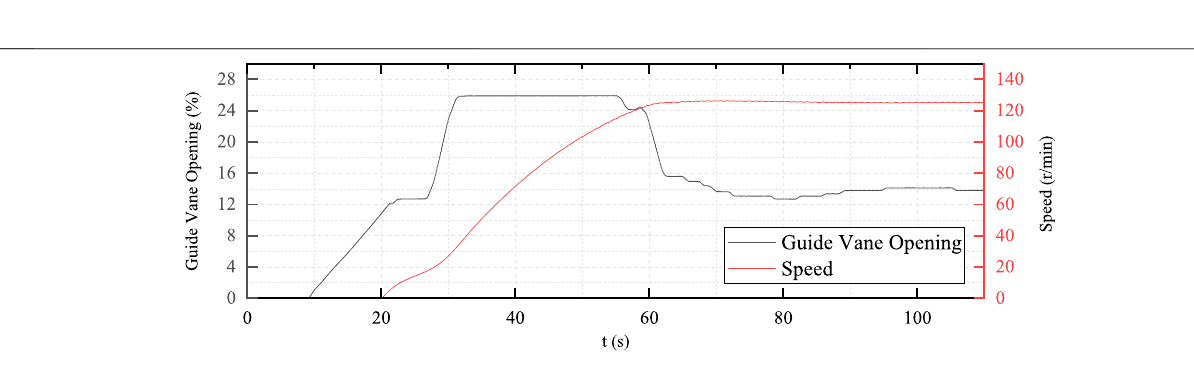
FIGURE 11 | The curve of the guide vane opening and the speed (two-stage acceleration).